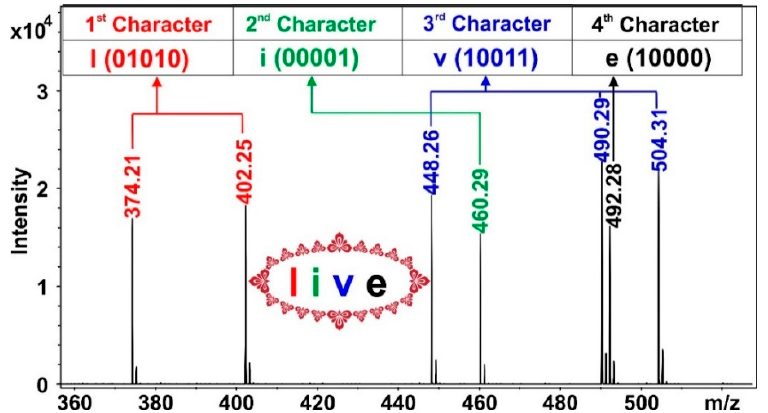
Figure 4. Decoding (reading) the "live" word from the text on the “Matyó” embroidery (shown in Figure 3) by MALDI-TOF MS.